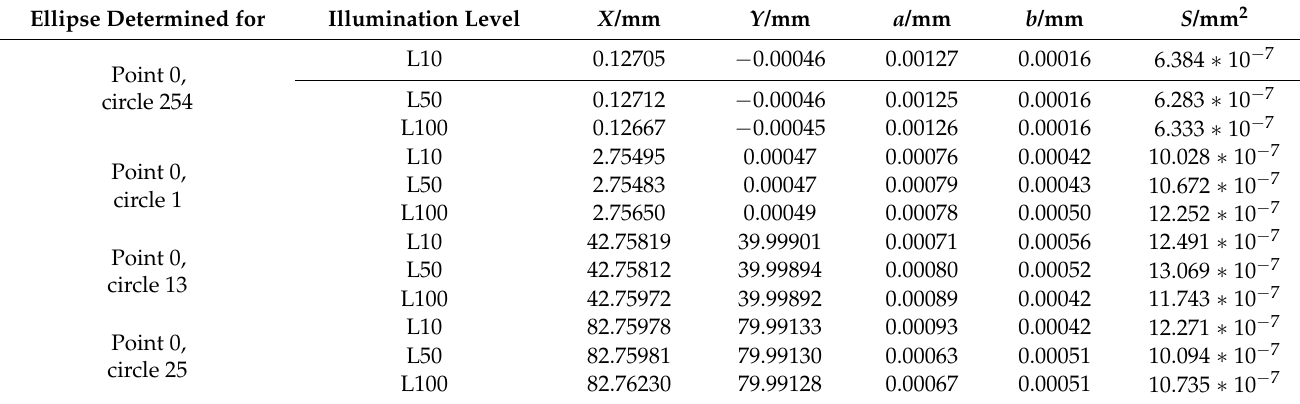
Table 1. Changes in areas of measuring point reproduction ellipses ( S ) caused by application of different illumination level during point